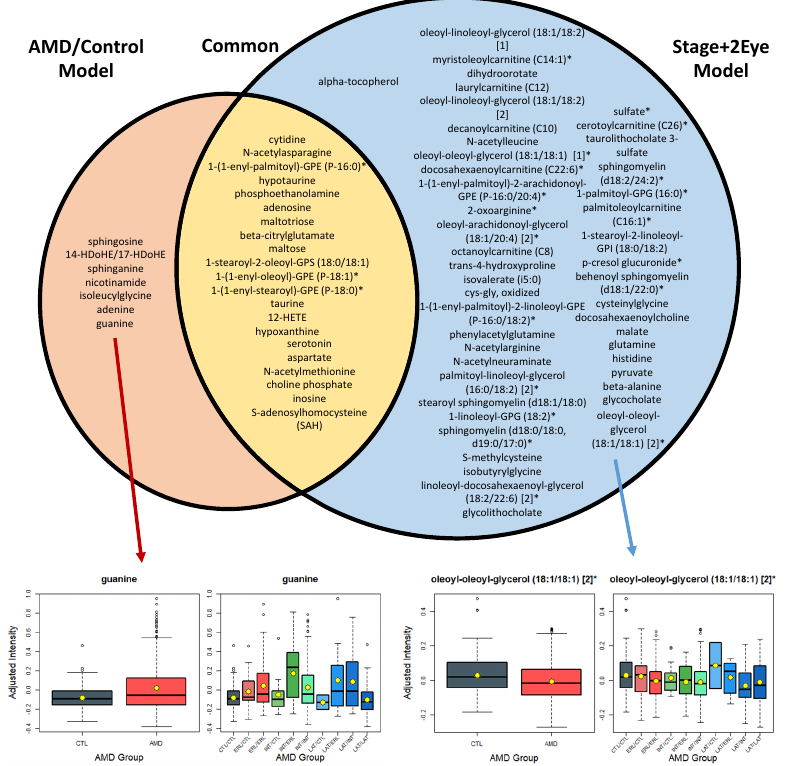
Figure 2. List of the metabolites di ff ering significantly ( q < 0.05) between AMD patients (AMD / Control model), and controls, and across AMD stages of both eyes (Stage + 2Eye model). AMD: age-related macular degeneration; CTL: control; ERL: early AMD; INT: intermediate AMD; LAT: late AMD. Box plots for the most statistically significant metabolites of each analysis are presented. For each box plot, yellow dots represent the mean and black horizontal lines represent the median; AMD / Control model: multivariable logistic regression model considering AMD versus controls as the outcome; Stage + 2Eye: permutation-based cumulative logistic regression model considering both eyes of each patient and the severity stage of disease as the outcome (control, early, intermediate, and